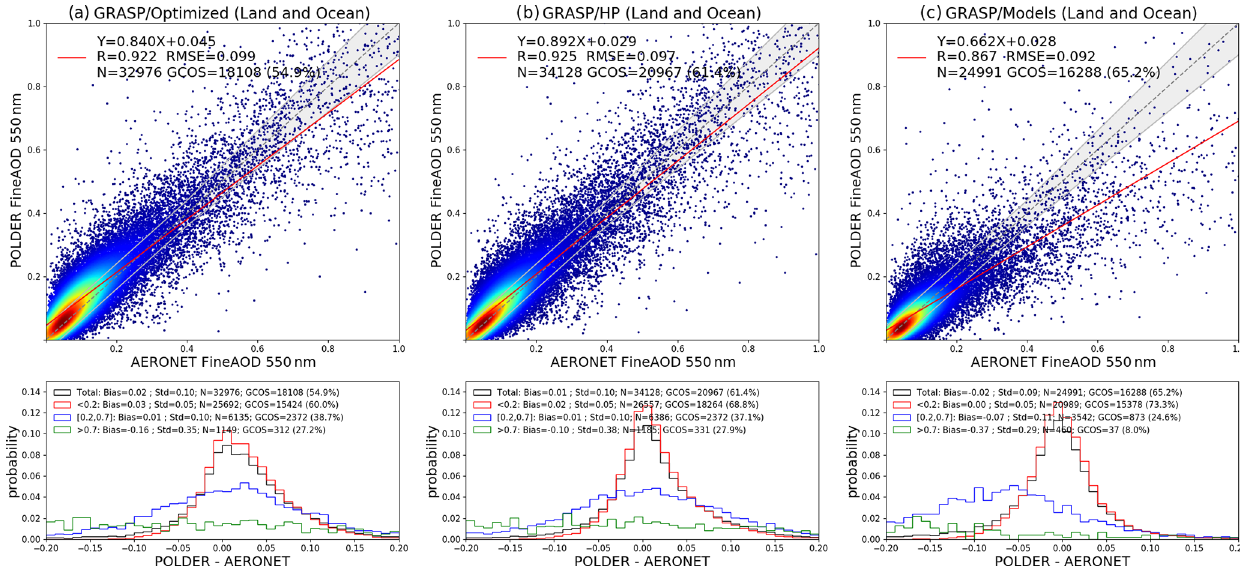
Figure 4. Evaluation of all archive PARASOL/GRASP AODF at 550nm with AERONET SDA AODF: (a) GRASP/Optimized, (b) GRASP/HP, (c) GRASP/Models. The gray dashed line and the red solid line are the 1 : 1 reference line and the linear regression line. The gray envelope indicates the GCOS requirement applied for AODF: max (0.04 or 0.1AODF). The probability density functions of differences (POLDER–AERONET) are present in the lower panel. The black, red, blue and green solid lines indicate all AODF conditions: any AODF, AODF < 0.2, 0.2 ≤ AODF ≤ 0.7 and AODF > 0.7, respectively. Table 6. Global statistics of PARASOL/GRASP AODC vs. AERONET SDA AODC at 550nm over land and ocean. The best performing of three approaches by each metric is labeled in bold. R Slope Offset RMSE GCOS Bias Bias Bias Bias fraction (%) τ c (550) <